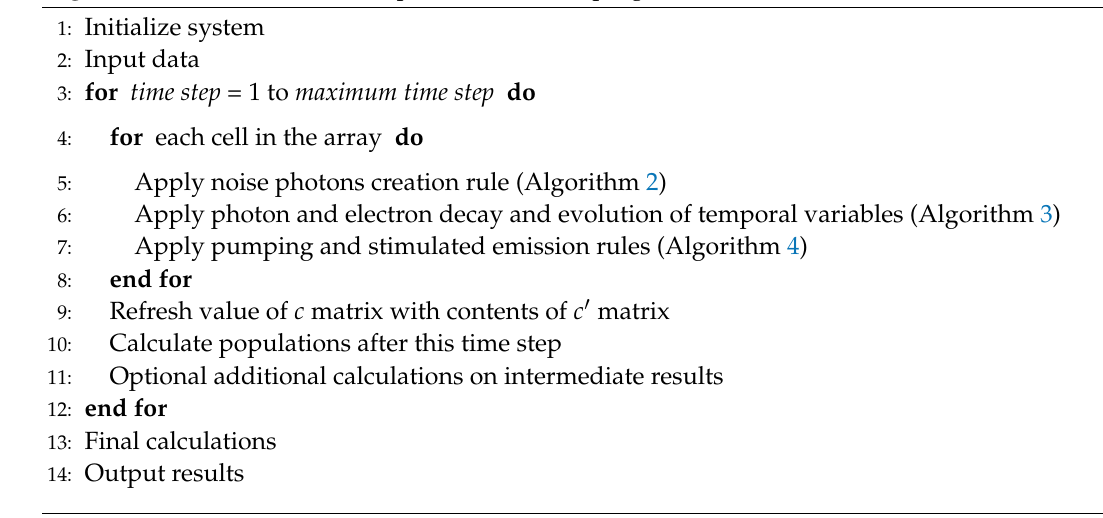
Algorithm 1 Pseudo code description of the main program for the CA laser